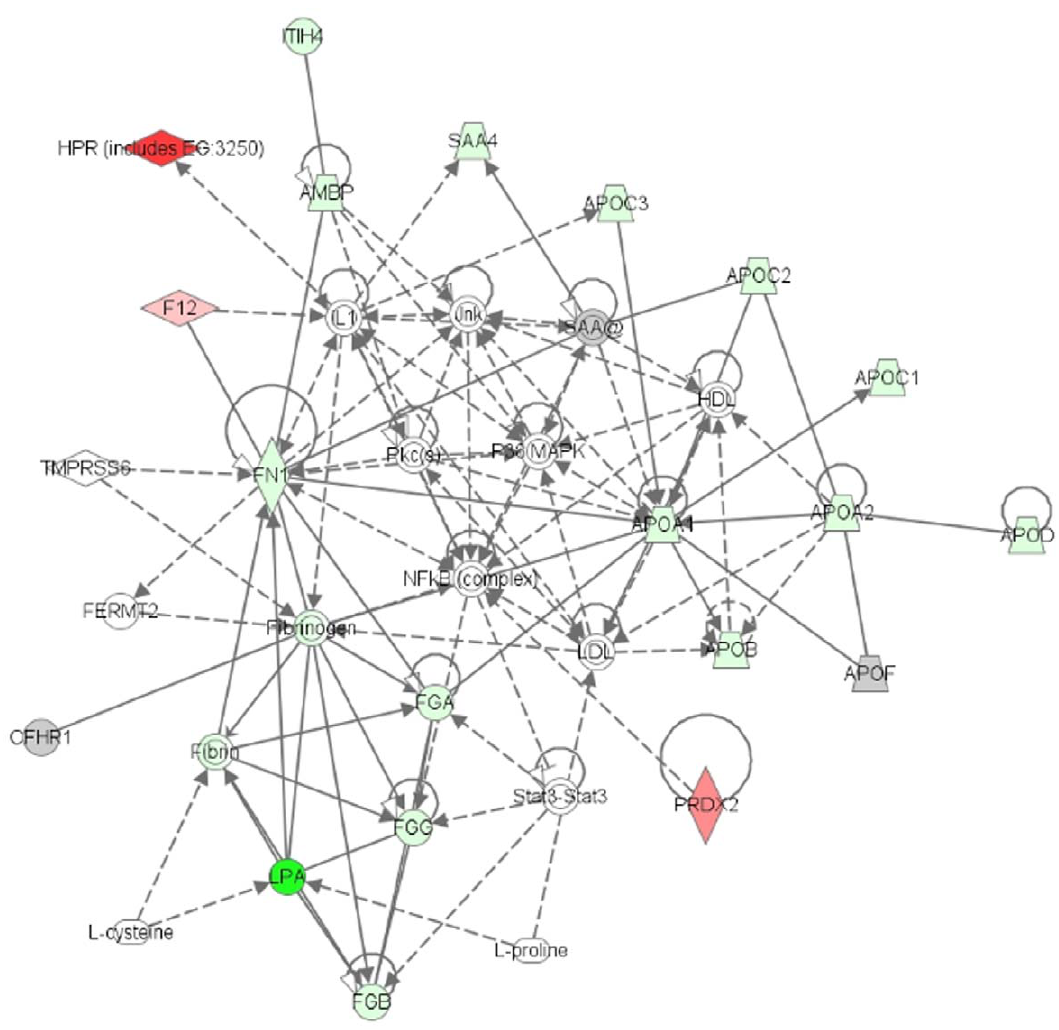
Figure 1. Network of differentially expressed plasma proteins of primigravid women with SA vesus primigravid women without SA. 24 proteins were eligible for network analysis by Ingenuity Pathways Analysis. The top-scoring network, illustrated here, included 18 focus proteins. Green and red symbols represent proteins that were down- and up-regulated during SA respectively. Gray symbols represent proteins identified in the study for which the difference in expression level did not achieve statistical significance. Direct and indirect interactions are represented by the solid and broken lines respectively.